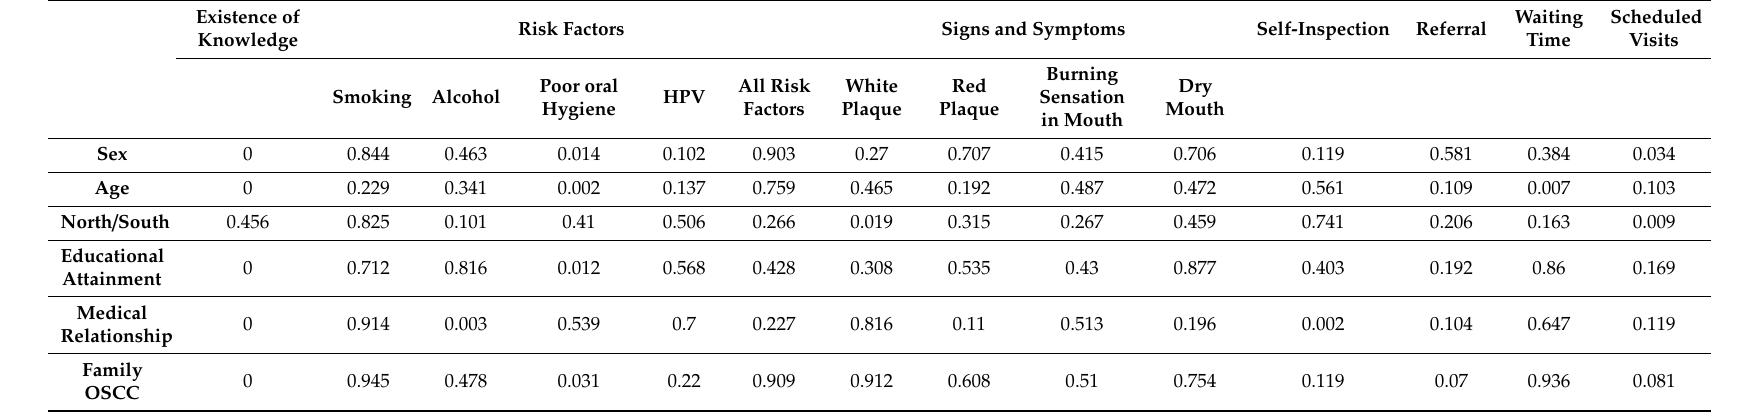
Table 1. Results of statistical